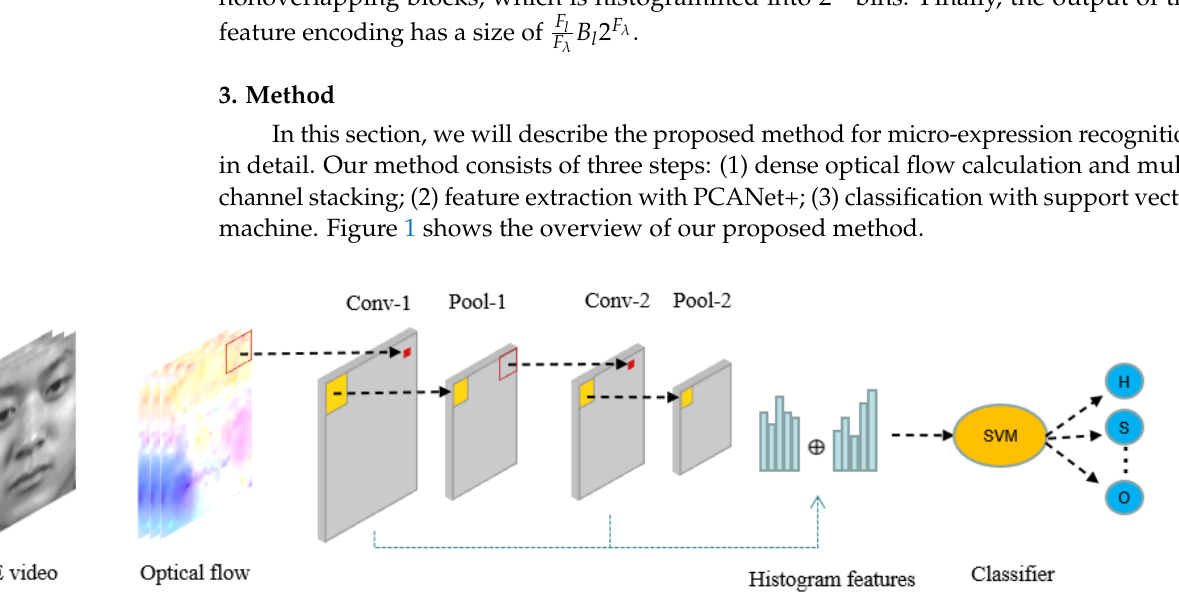
Figure 1. The framework of the proposed ME recognition